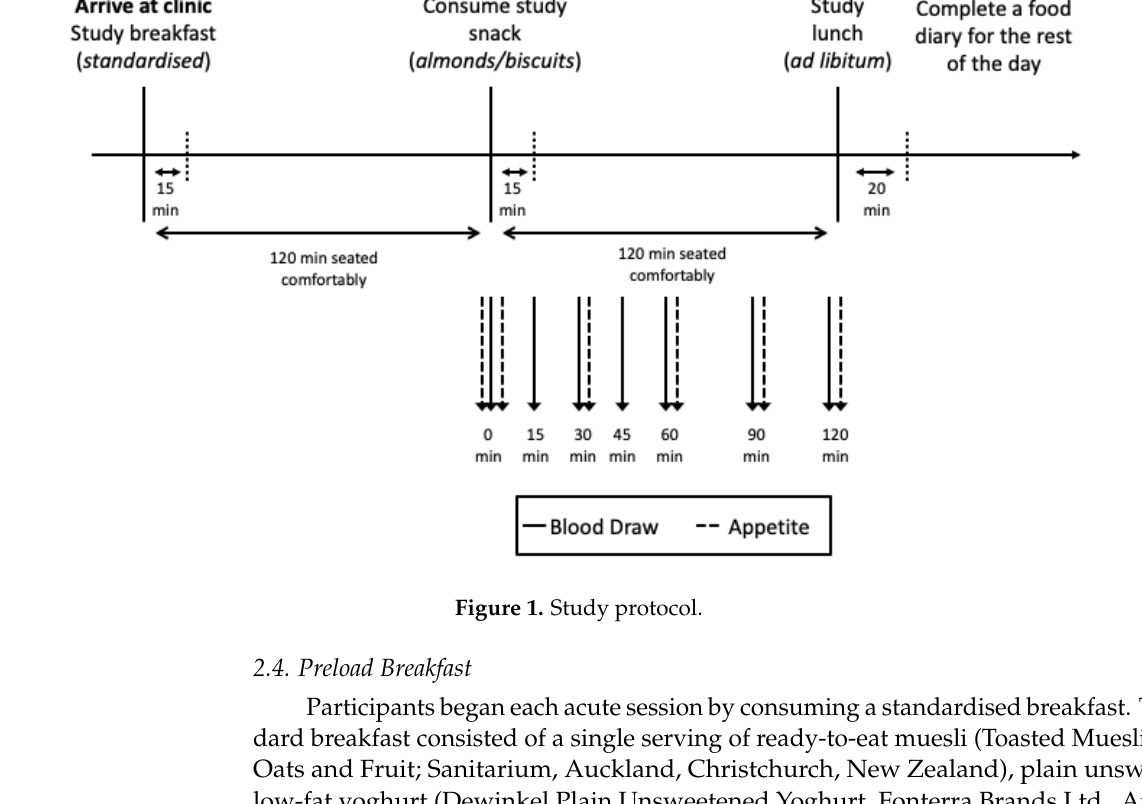
Figure 1. Study protocol.